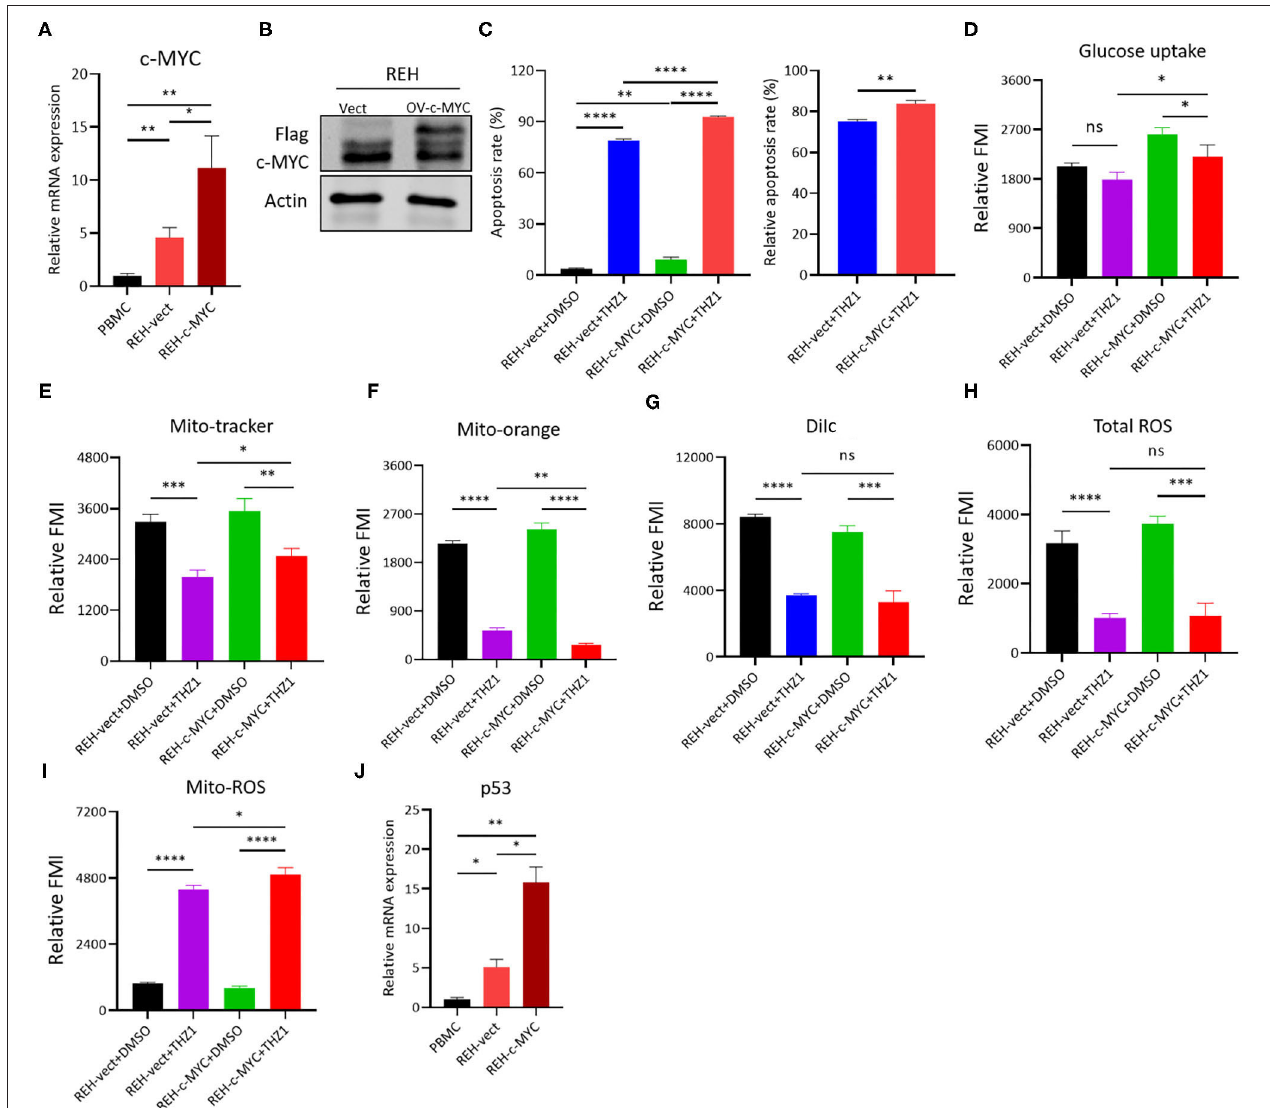
FIGURE 7 | THZ1 enhances cell apoptosis in c-MYC-overexpressed B-ALL cells. (A,B) Overexpressed mRNA and protein levels of c-MYC in REH cells was detected by qRT-PCR and Western blot, respectively. (C) Annexin V- and PI-labeled cell apoptosis of c-MYC-overexpressed REH cells were analyzed by flow cytometry. (D) Glucose uptake of vector and c-MYC-overexpressed REH cells was analyzed by flow cytometry. (E–H) Mitochondrial membrane potential (MMP), mitochondrial mass (MM), and total ROS of vector and c-MYC-overexpressed REH cells were analyzed by flow cytometry. (I) The mitochondrial ROS (Mito-ROS) of vector and c-MYC-overexpressed REH cells were analyzed by flow cytometry. (J) The mRNA expression of p53 in vector and c-MYC-overexpressed REH cells were determined by qRT-PCR. B-ALL cells were treated with THZ1 for 24h. Values were shown as mean ± SEM. * p < 0.05, ** p < 0.01, *** p < 0.001, and **** p <